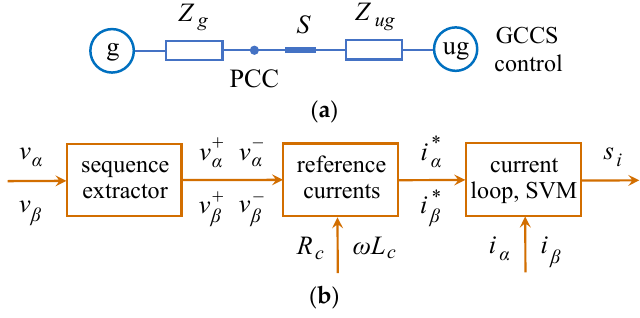
Figure 3. GCCS control schemes: ( a ) diagram of the power system; ( b ) diagram of the control scheme.